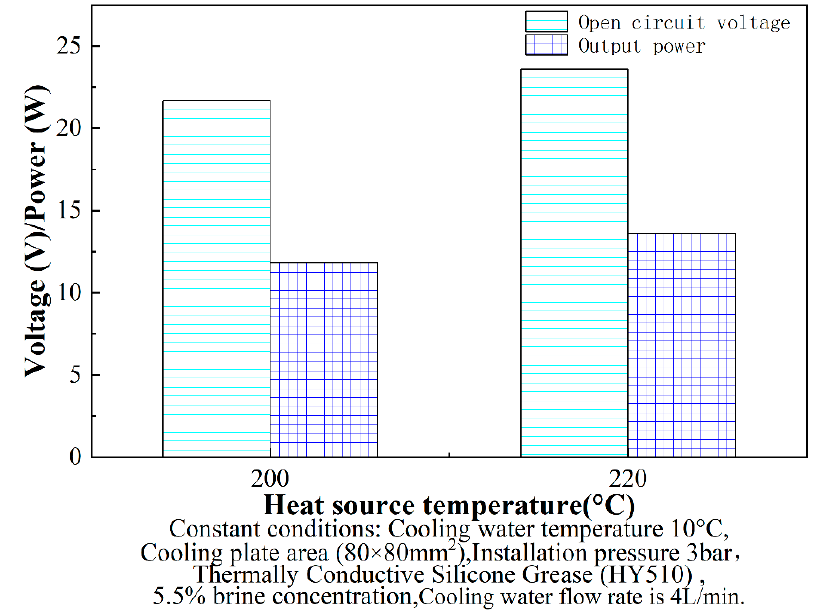
Figure 11. Effect of heat source temperature on open-circuit voltage and output power.